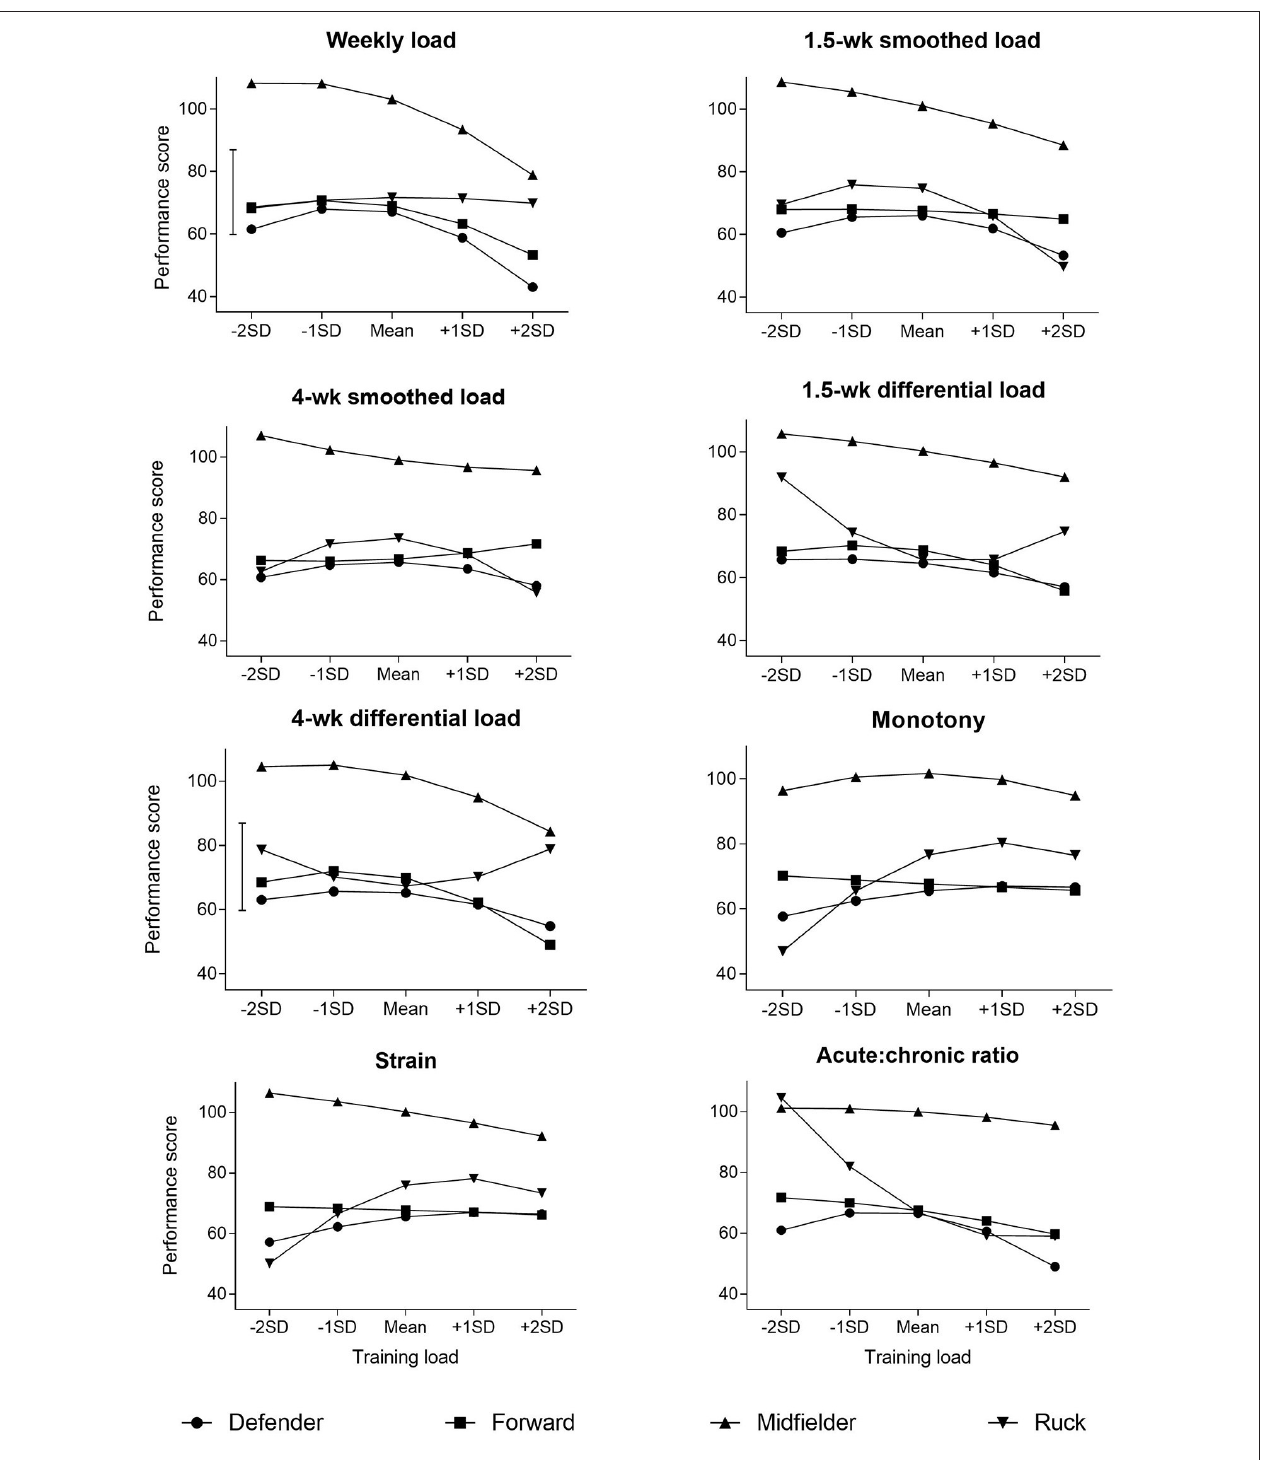
FIGURE 1 | The effect of training measures on performance score. Data are presented as predicted performance scores for the mean training measure and two within-player SD below and above the mean. The capped line represents the observed between-SD averaged over each position, which is used to derive the smallest important change by multiplying by 0.2. The observed between-SD for all training measures and position groups is ∼ 25.